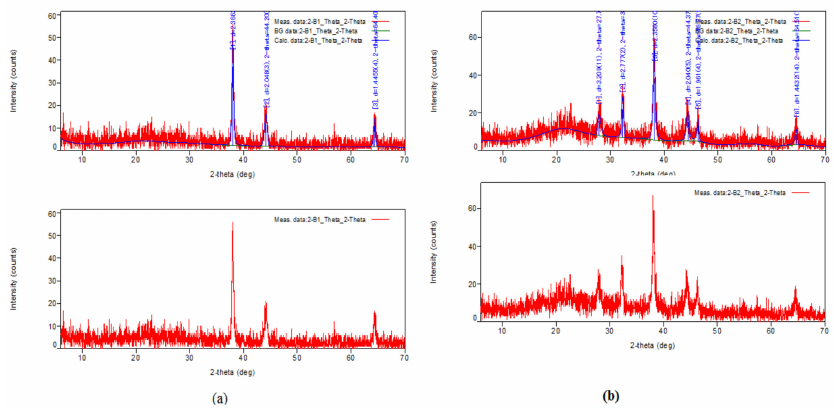
Figure 4. XRD profile of nanoconjugates formed from ( a ) aqueous extract and ( b ) methanolic extract.